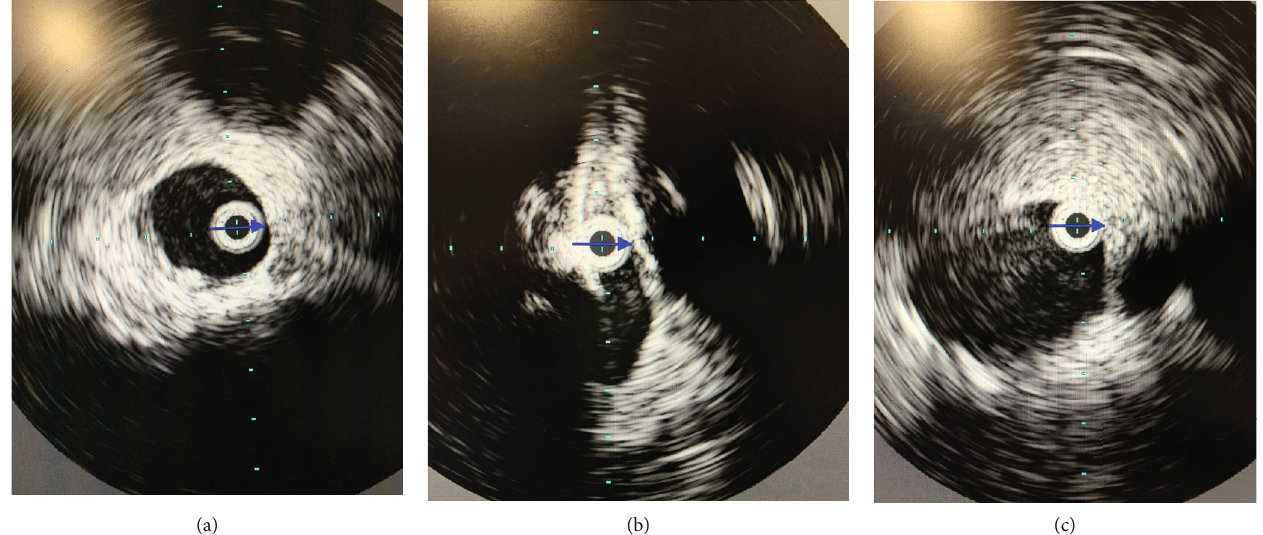
Figure 4: Intravascular ultrasound (IVUS) of the iliac vein: (a) precompression; (b) site of compression; (c) postcompression.